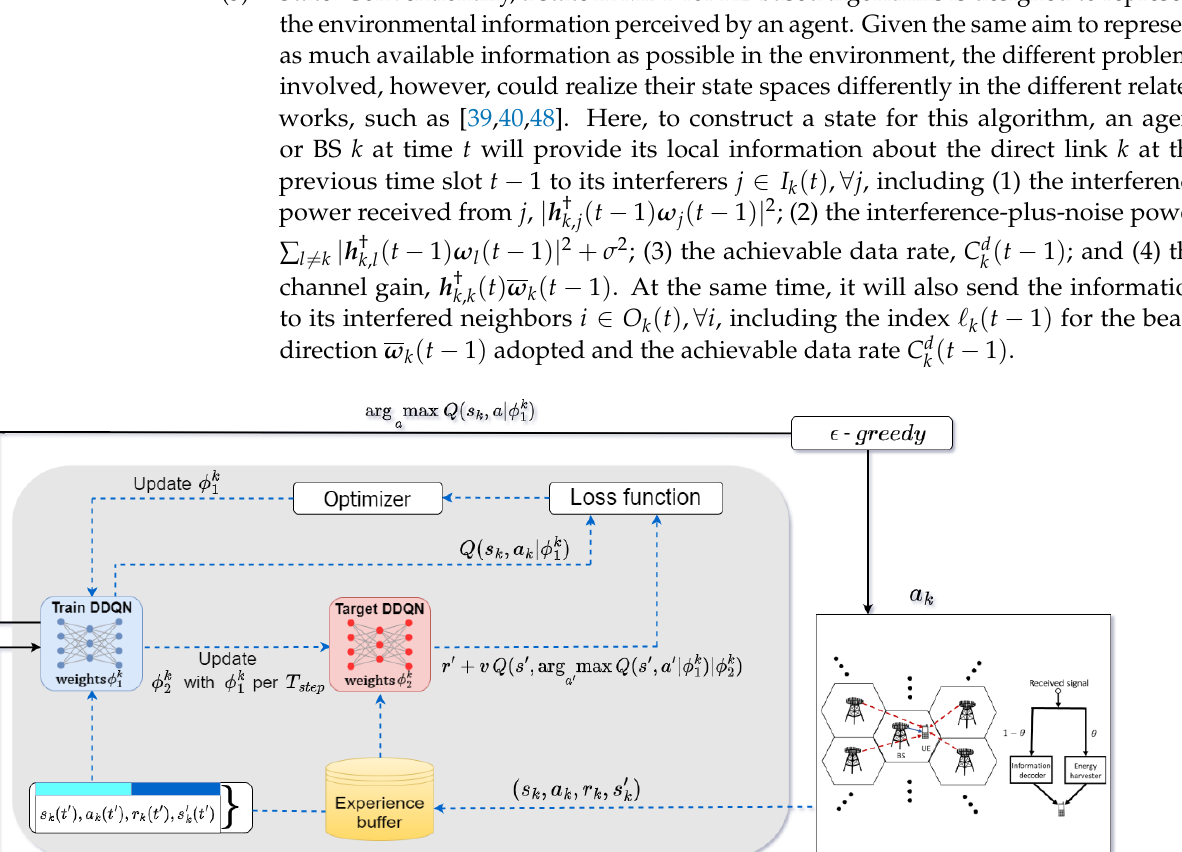
( t − 1 ) to agent k . Similarly, each interfered j